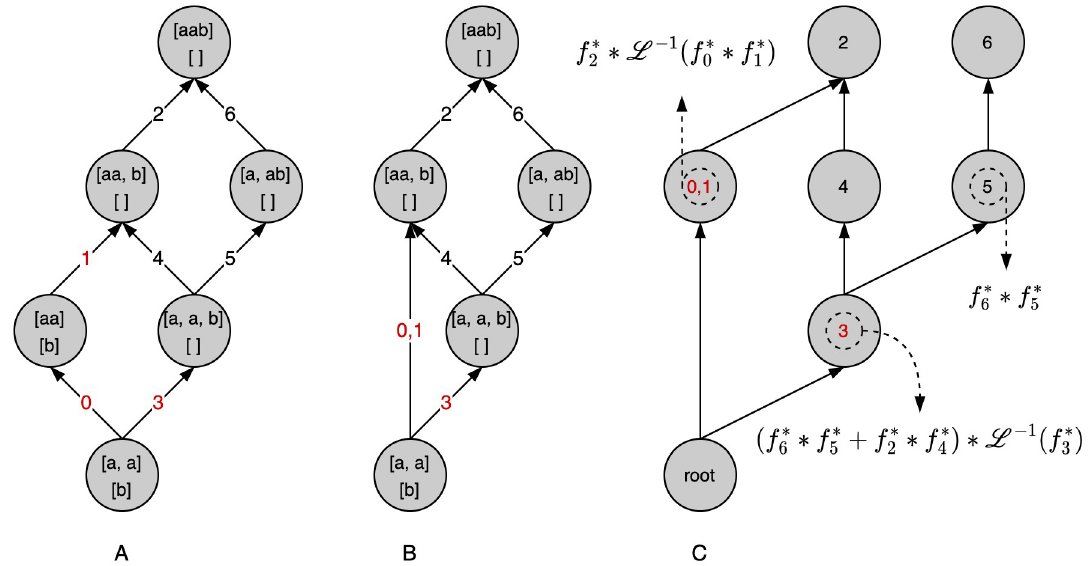
Fig 2. From coalescent state space to computational graph: State space graph and model identical to Fig 1. A: Unmodified state- space graph. B: Collapsed form, grouping all parts of each path that require inverting with respect to the dummy variable associated with the discrete event. The integers in red are the indices of the equations containing δ . C: To simplify the formulated algorithms, nodes represent the equations previously associated with the edges. The graph has been annotated to demonstrate the general propagation algorithm of the evaluated equations associated with each node towards the root. L (cid:0) 1 ð f ? respect to δ .